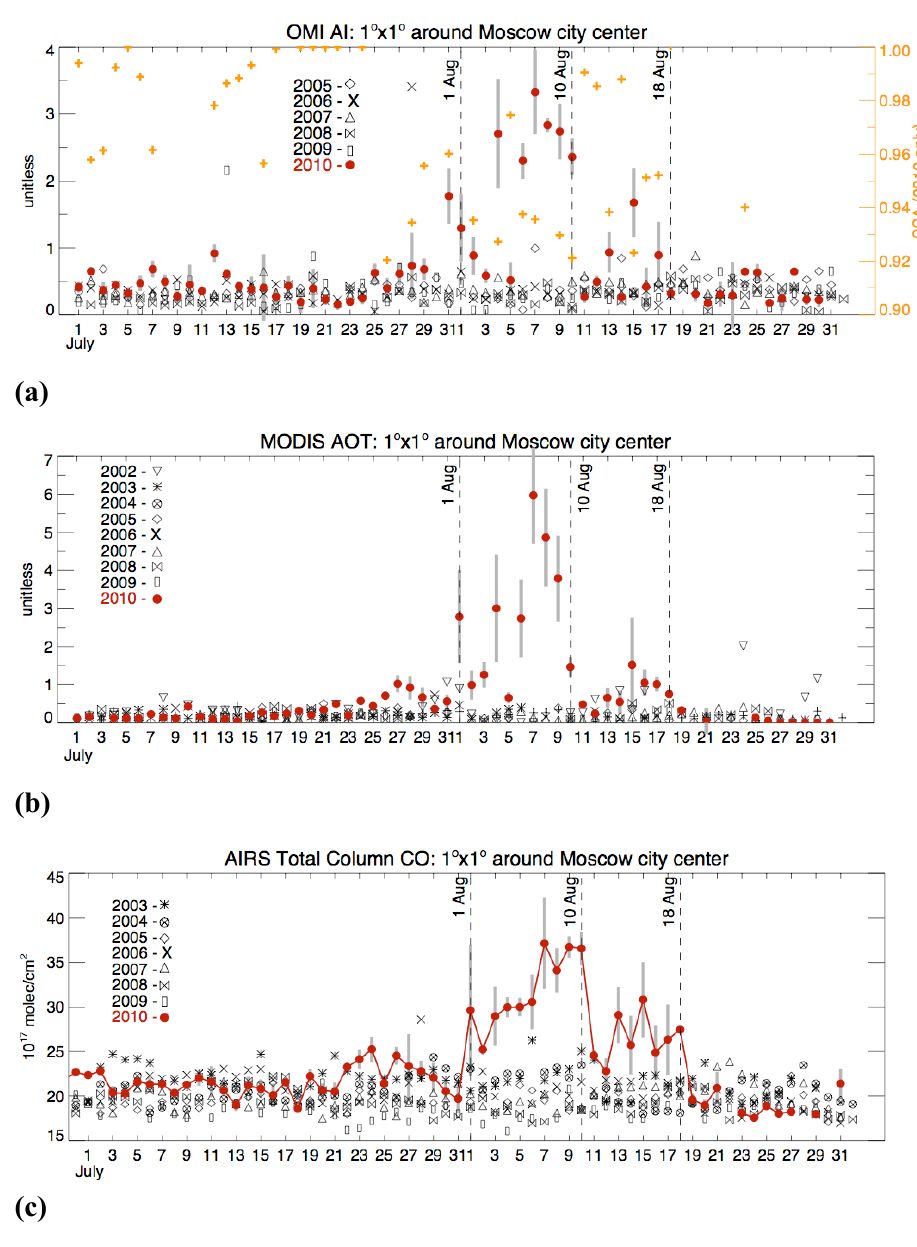
Figure 7. (a) Daily OMI AI and SSA (2010 only) per year over Moscow between July and August. This is the same domain as the statistics listed in Table 2. The 1-sigma standard deviation of SSA is within the uncertainty ( ± 0.03). (b) Daily MODIS AOT . 55 and (c) AIRS CO TC plotted similar to (a) . AOT . 55 are the average of Aqua and Terra MODIS values. The 1- σ standard deviations are plotted for 2010 only in grey